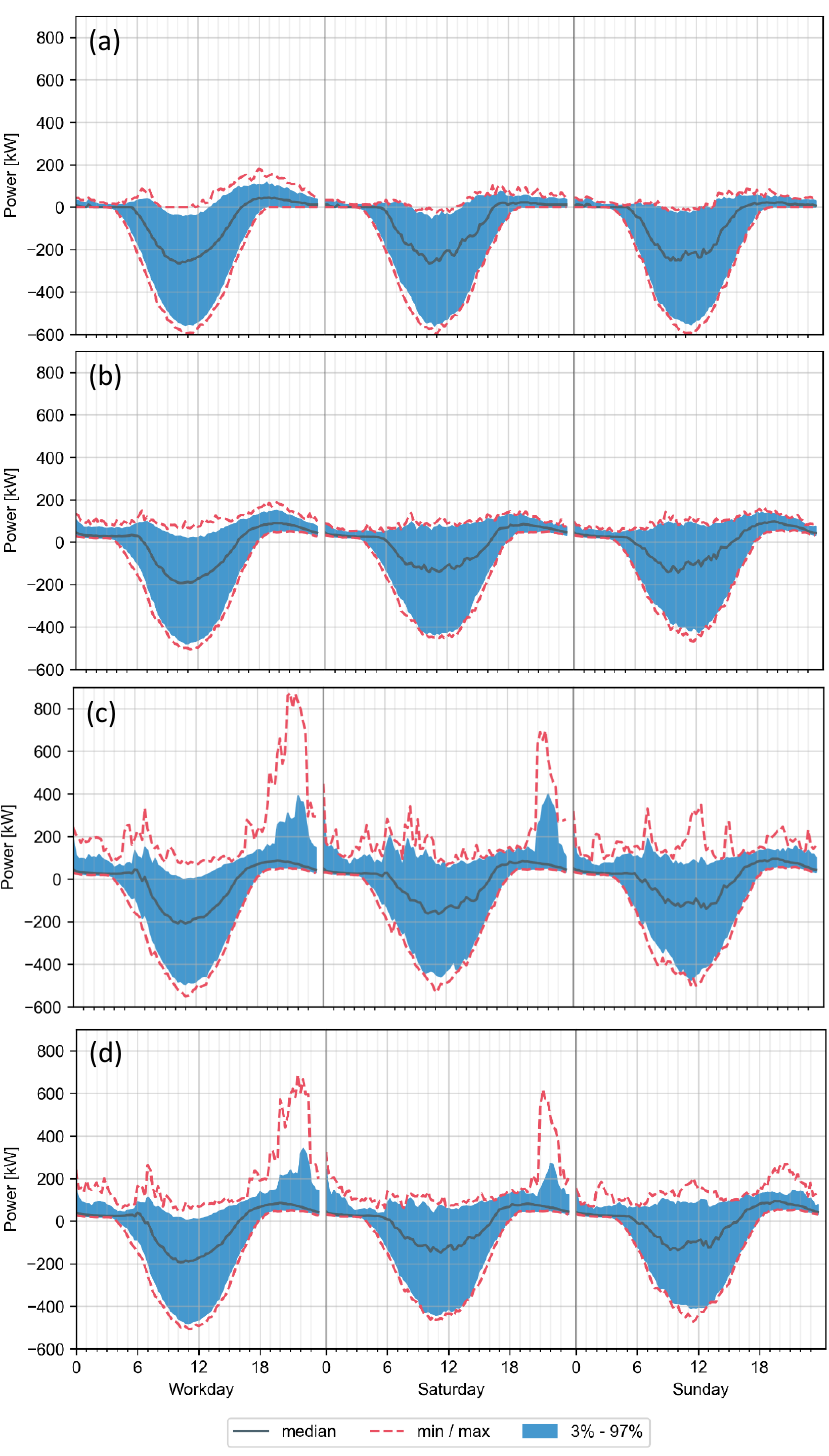
Figure 21. Grid load of the aggregated pool of all 100 households for ( a ) ’Direct Charging’ con- figuration, ( b ) ’PV Optimized Charging’ , ( c ) ’Price Optimized Charging’ , ( d ) ’Combined Price + PV Optimized Charging’ .